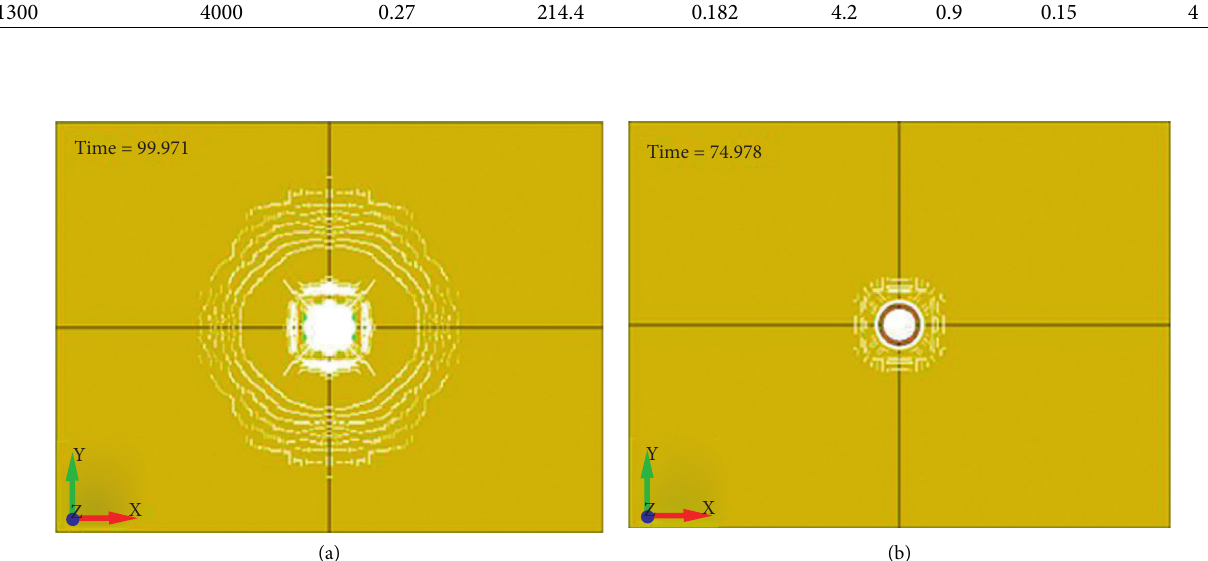
Figure 10: Distribution of damage zone around blast holes with and without a steel pipe (Case I P 1 � 0MPa). (a) Damage zone around the blast hole without steel pipe. (b) Damage zone around the blast hole with a steel pipe.